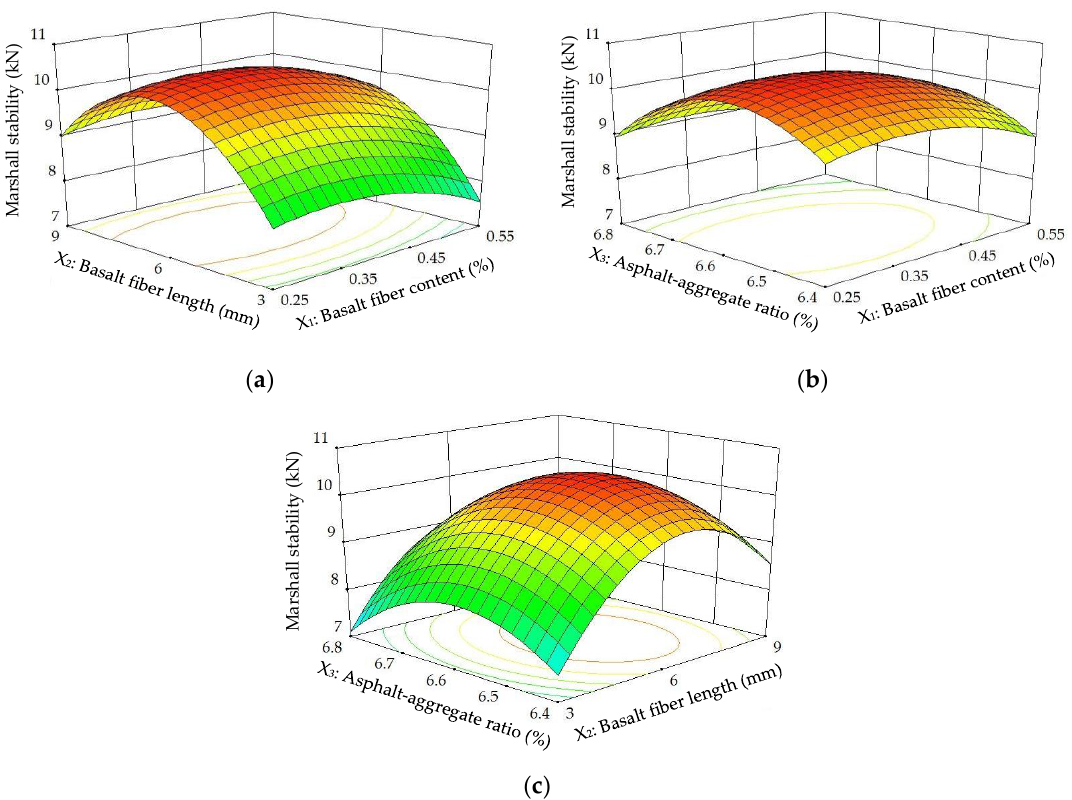
Figure 7. Response surface plots between MS and factors: ( a ) Factors: BFC and BFL at AAR = 6.6%; ( b ) Factors: BFC and AAR at BFL = 6 mm; ( c ) Factors: BFL and AAR at BFC = 0.4%.